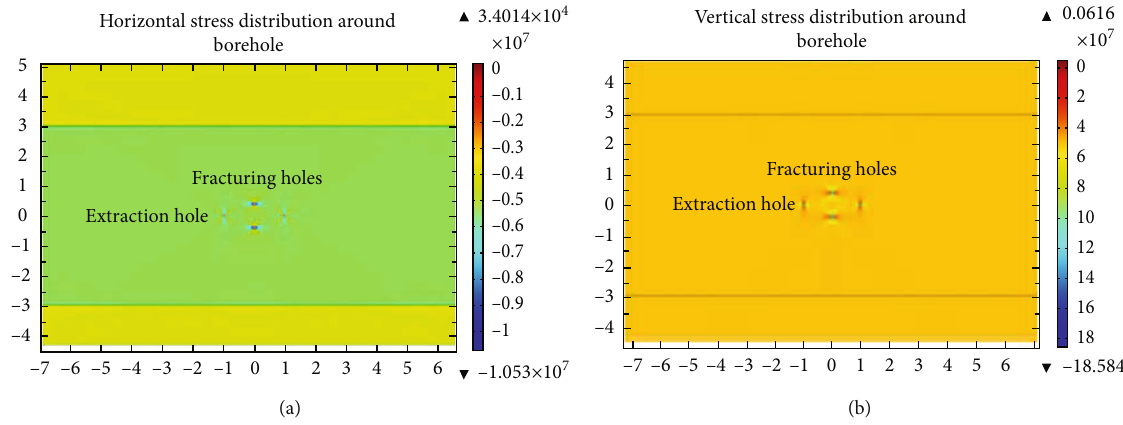
Figure 9: Stress distribution map of two-hole fracturing with 2 m spacing between pumping holes.